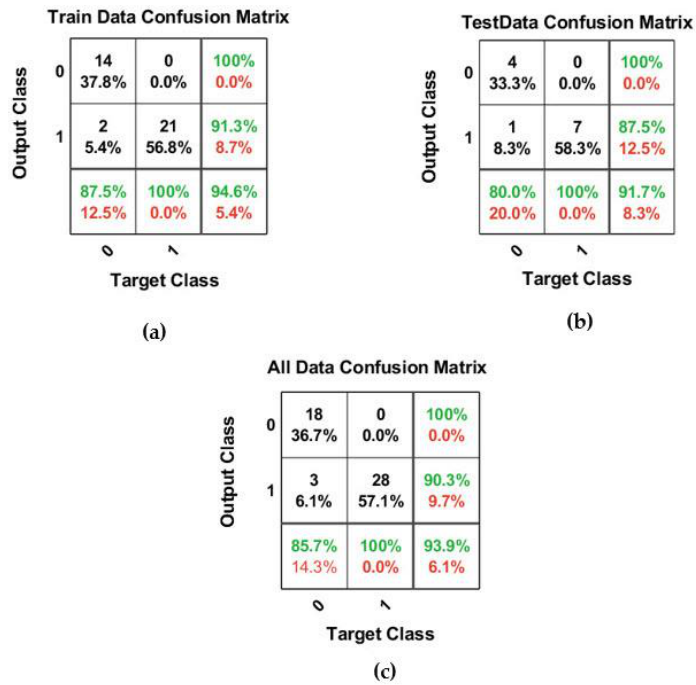
Figure 6. Results of the confusion matrix for training data ( a ), testing data ( b ), and total data ( c ) for k* = 0.3. By modeling different trial and error techniques, the best structure of the binary clas-